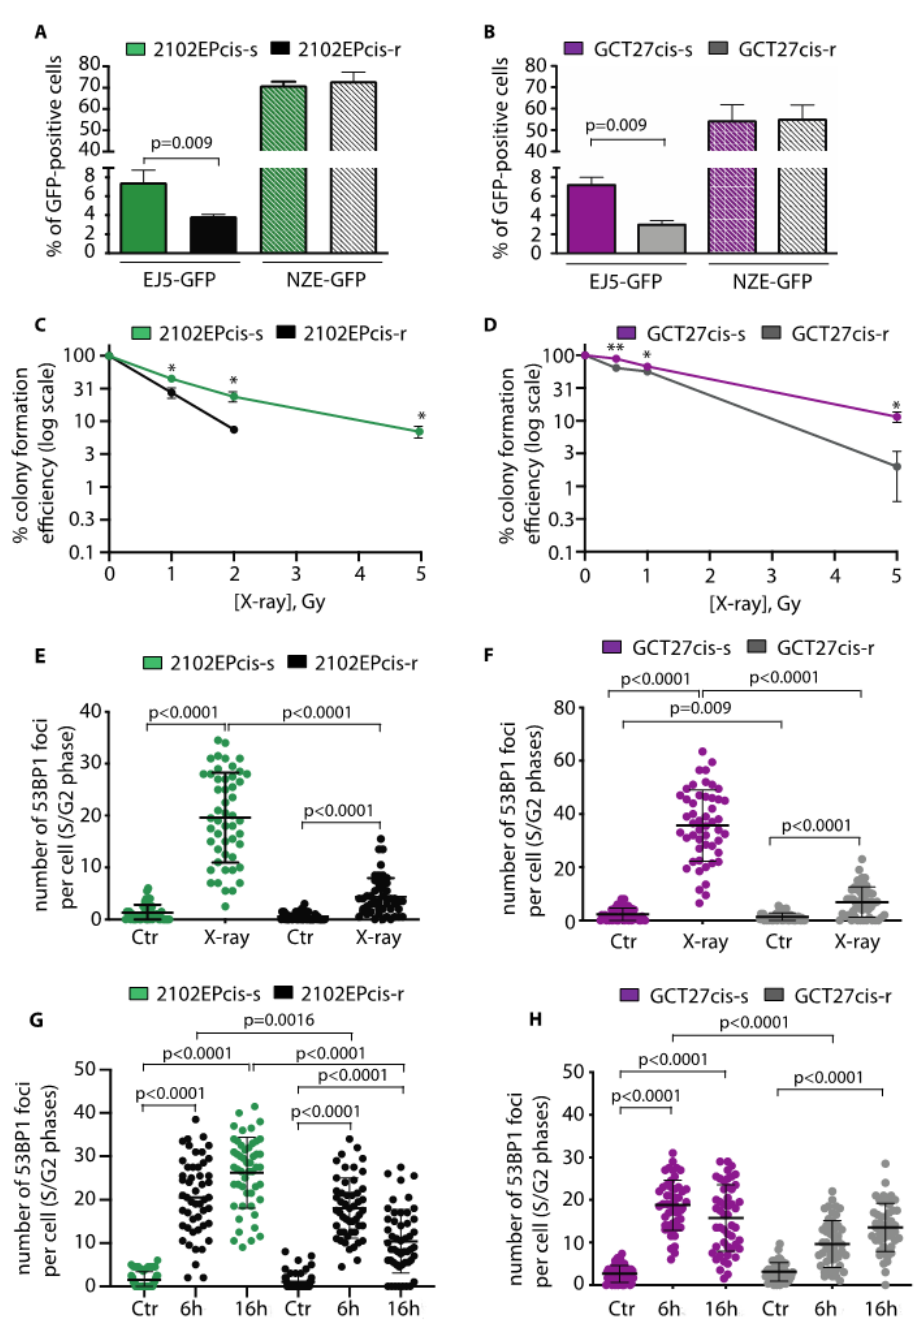
Figure 4 Figure 4. ( A , B ) NHEJ repair proficiency of GCT27 and 2102EP cell lines as measured by the EJ5-GFP reporter substrate. NZE-GFP indicates the transfection efficiency of each cell line. Data are mean values ± s.d. of three independent experiments. ( C , D ) Colony assay of the indicated cell lines treated with the indicated doses of X-rays. The surviving fraction was monitored by following colony formation for up to 10 to 14 days after treatment. Data are mean values ± s.d. of two independent experiments, each performed in triplicate. ( E , F ) Quantification of 53BP1 foci in S/G2 (cyclin A- positive) nuclei of the indicated cell lines after X-ray treatment. Data are mean values ± s.d. of three independent experiments. ( G , H ) Quantification of 53BP1 foci in S/G2 nuclei of the indicated cell lines after cisplatin treatment. Cells were treated with a 6 h pulse of 3 µ M cisplatin and collected at the end of stimulation and 16 h after drug washout. Data are mean values ± s.d. of three independent experiments. Statistical analyses were performed using an unpaired two-tailed ( A , B , E – H ) or one- tailed ( C , D ) t -test (* p < 0.05; ** p <